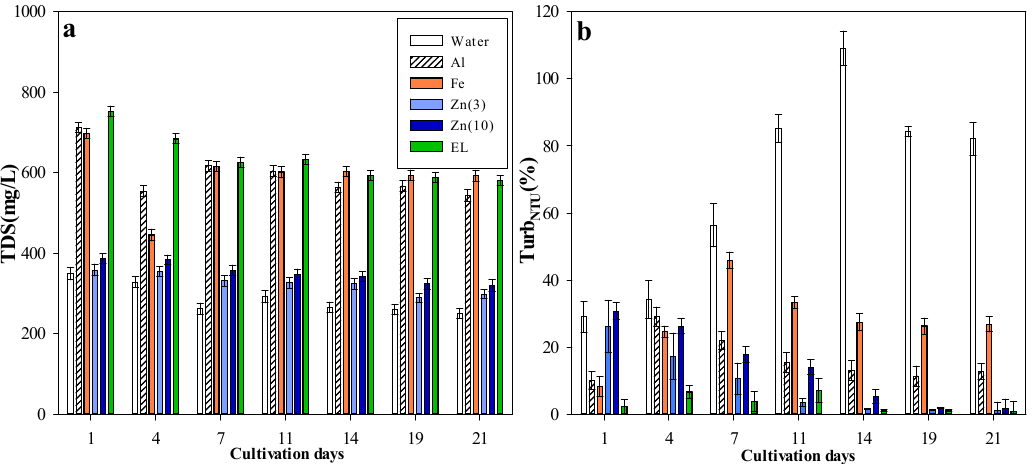
Figure 5. Variations in mean (±S.D.) total dissolved nitrogen and turbidity of water in the different treatments. TDS and Turb NTU color (456 nm) were the total dissolved solids and turbidity NTU in 456 nm, respectively ( a is TDS, b is Turb).